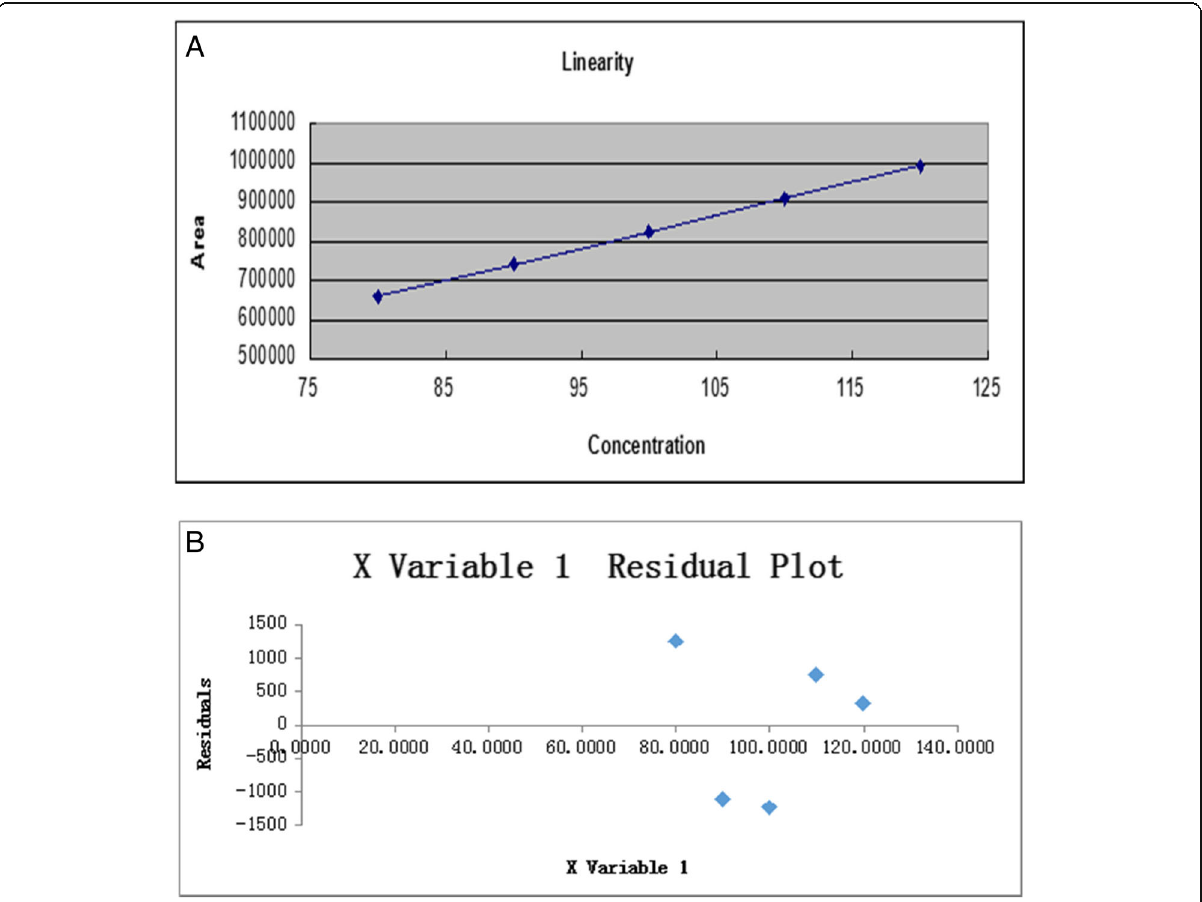
Fig. 6 a Linearity graph of fulvestrant from 80 μ g mL − 1 to 120 μ g mL-1. b Residuals for of detector response of